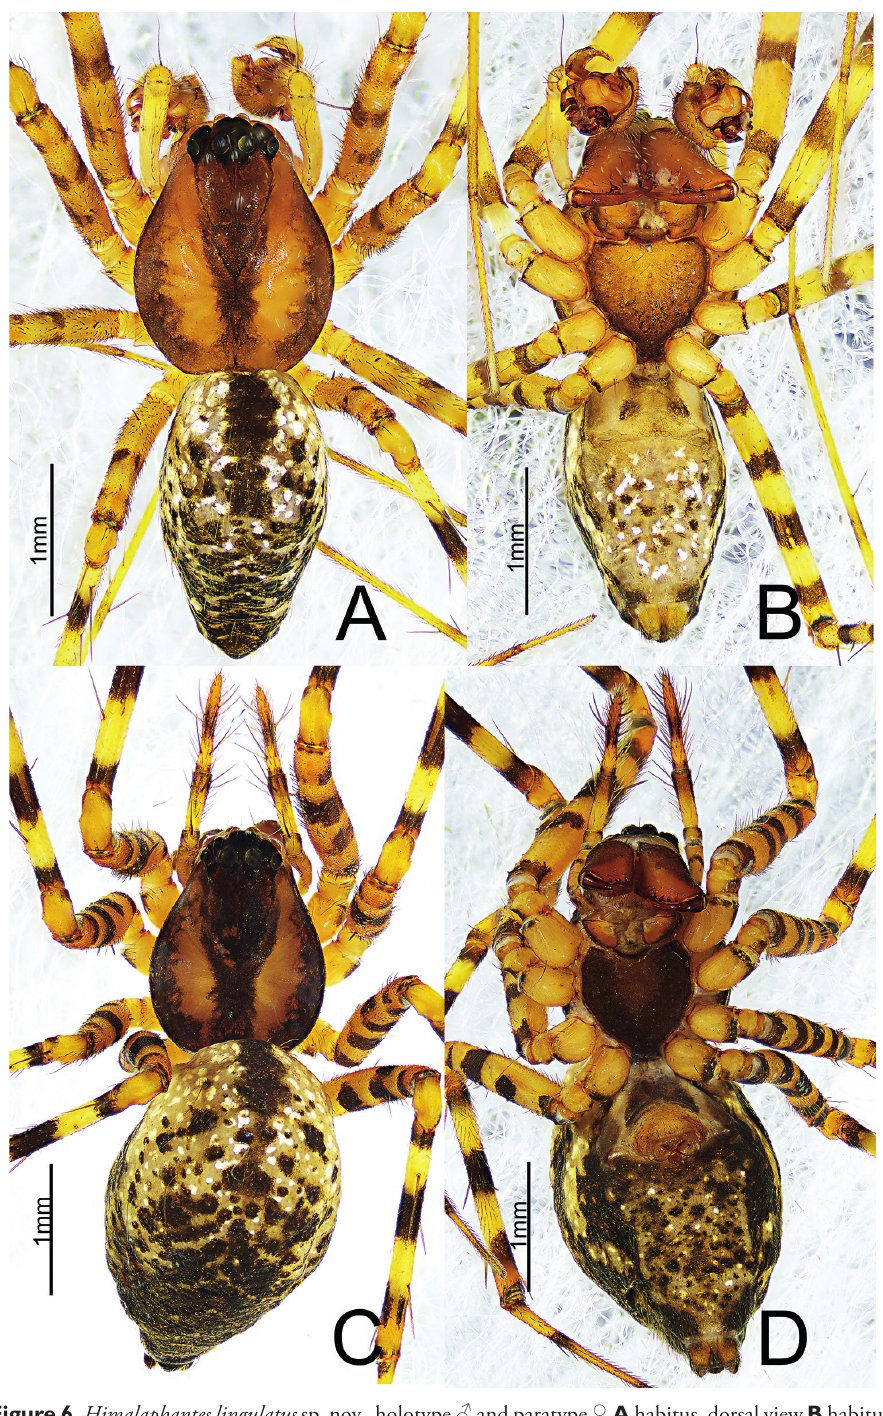
Figure 6. Himalaphantes lingulatus sp. nov., holotype ♂ and paratype ♀ A habitus, dorsal view B habitus, ventral view C habitus, dorsal view D habitus, ventral